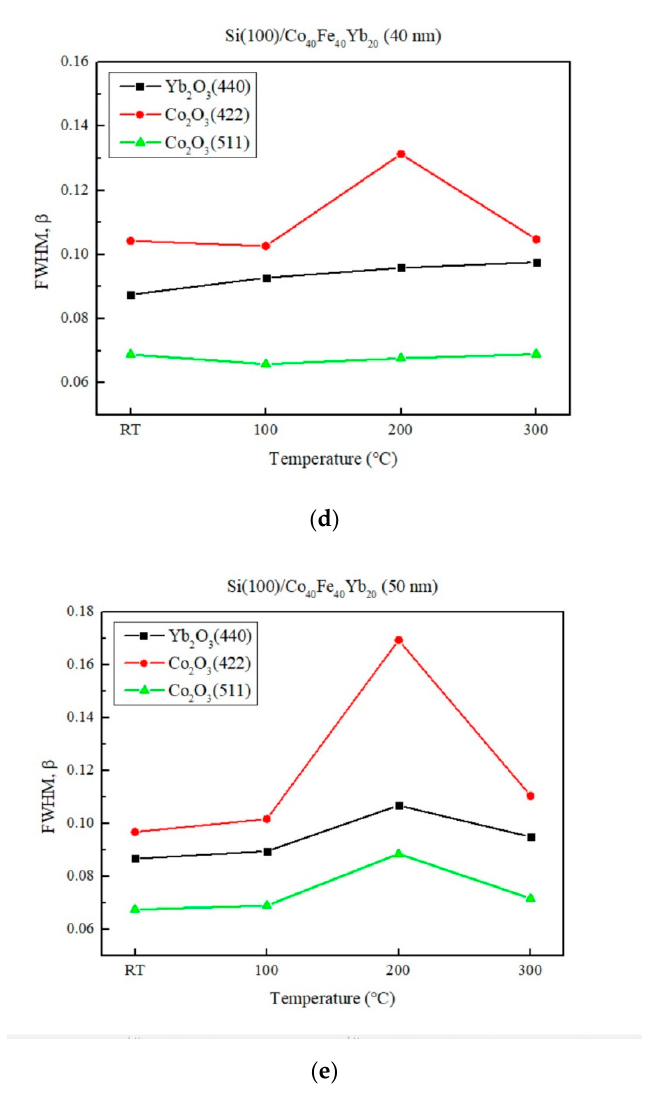
Figure 3. FWHM of the oxide peaks in Co 40 Fe 40 Yb 20 films under different conditions. ( a ) 10 nm, ( b ) 20 nm, ( c ) 30 nm, ( d ) 40 nm, and ( e ) 50 nm.